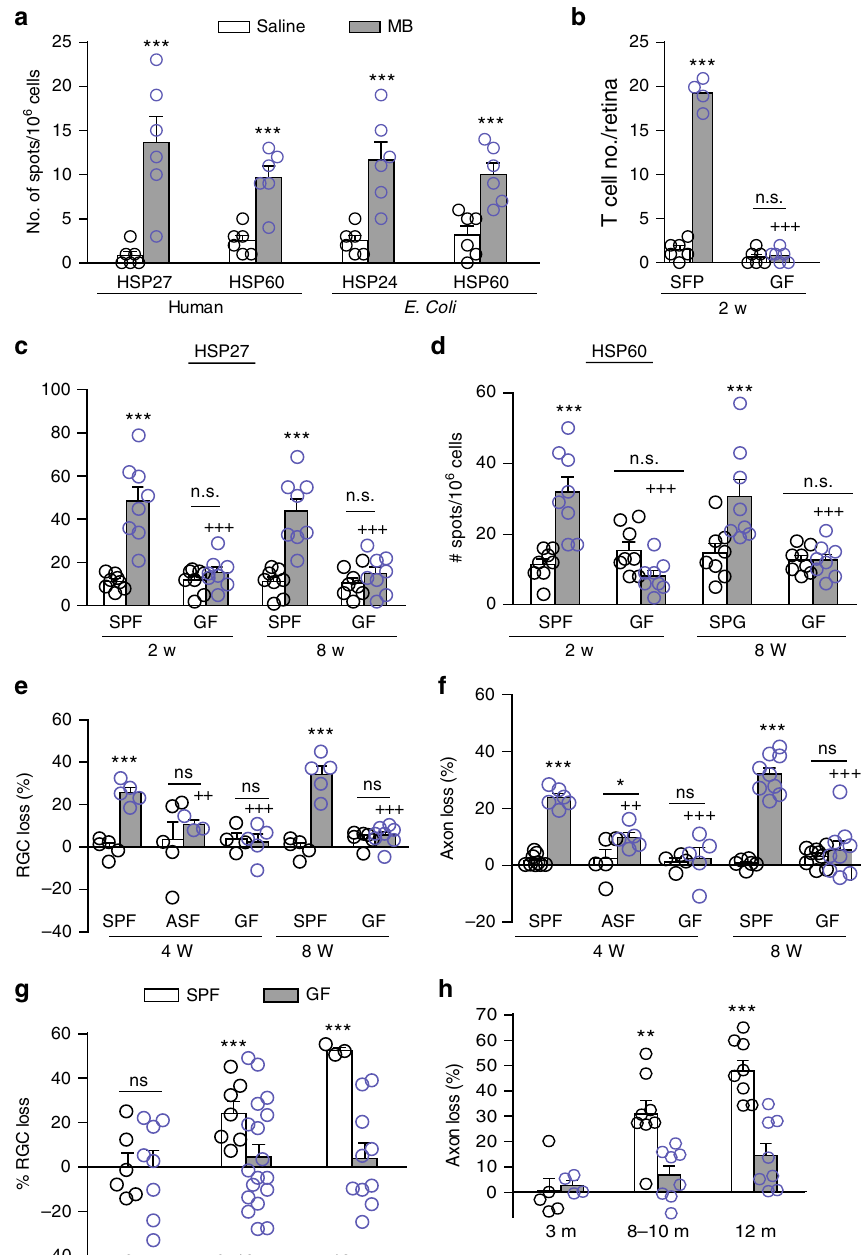
Fig. 5 HSP-speci fi c T-cell responses and retinal damage are absent in germ-free mice. a Frequencies of T-cell responses to human and bacterial HSPs. Splenocytes from mice at 2 weeks post saline or MB injection were stimulated with human HSP27 and HSP60 or E. coli HSP24 and HSP60, and the frequencies of IFN- γ -secreting cells were assayed by ELISPOT ( n = 6/group). b Quanti fi cation of in fi ltrated T cells in the retinas of SPF and GF SW mice at 2 weeks after saline or MB injection ( n = 6/group). c , d Frequencies of HSP27 ( c )- and HSP60 ( d )-speci fi c T cells in GF and SPF Swiss Webster mice ( n ≥ 8/group). Splenocytes from GF and SPF Swiss Webster mice at 2 and 8 weeks post MB or saline injection were stimulated with human HSP27 or HSP60, and the frequencies of IFN- γ -secreting cells were assayed by ELISPOT. n.s. not signi fi cant. e , f Comparison of RGC ( e ) and axon ( f ) loss at 4 and 8 weeks after MB injection in SPF, ASF, and GF Swiss Webster mice. * P <0.05; *** P < 0.001 over saline-injected group; ++ P < 0.01; +++ P < 0.001 over MB-injected SPF mice at the indicated time points. n.s. not signi fi cant ( n = 8/group). g , h Comparison of RGC ( g ) and axon ( h ) loss in SPF and GF DBA/2J mice at 3 ( n = 16), 8 – 10 ( n = 24), and 12 ( n = 12) months of age. n.s. not signi fi cant; ** P < 0.01, *** P < 0.001 by